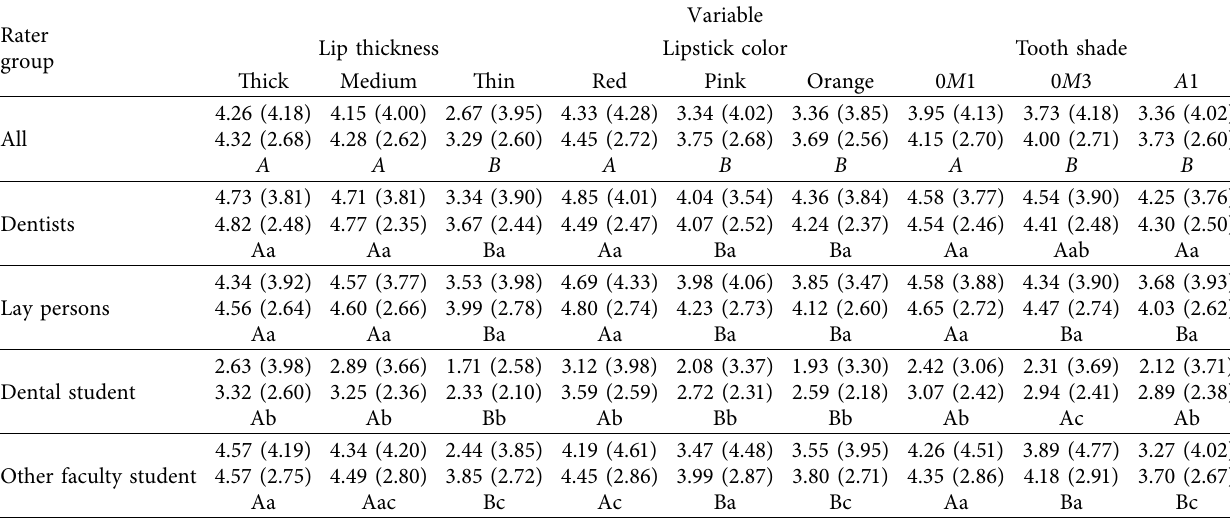
Table 2: Median (interquartile range) and mean (standard deviation) of the visual analog scale score for smile attractiveness perception as evaluated by each variable (lip thickness, lipstick color, and tooth shade) by all participants and each rater